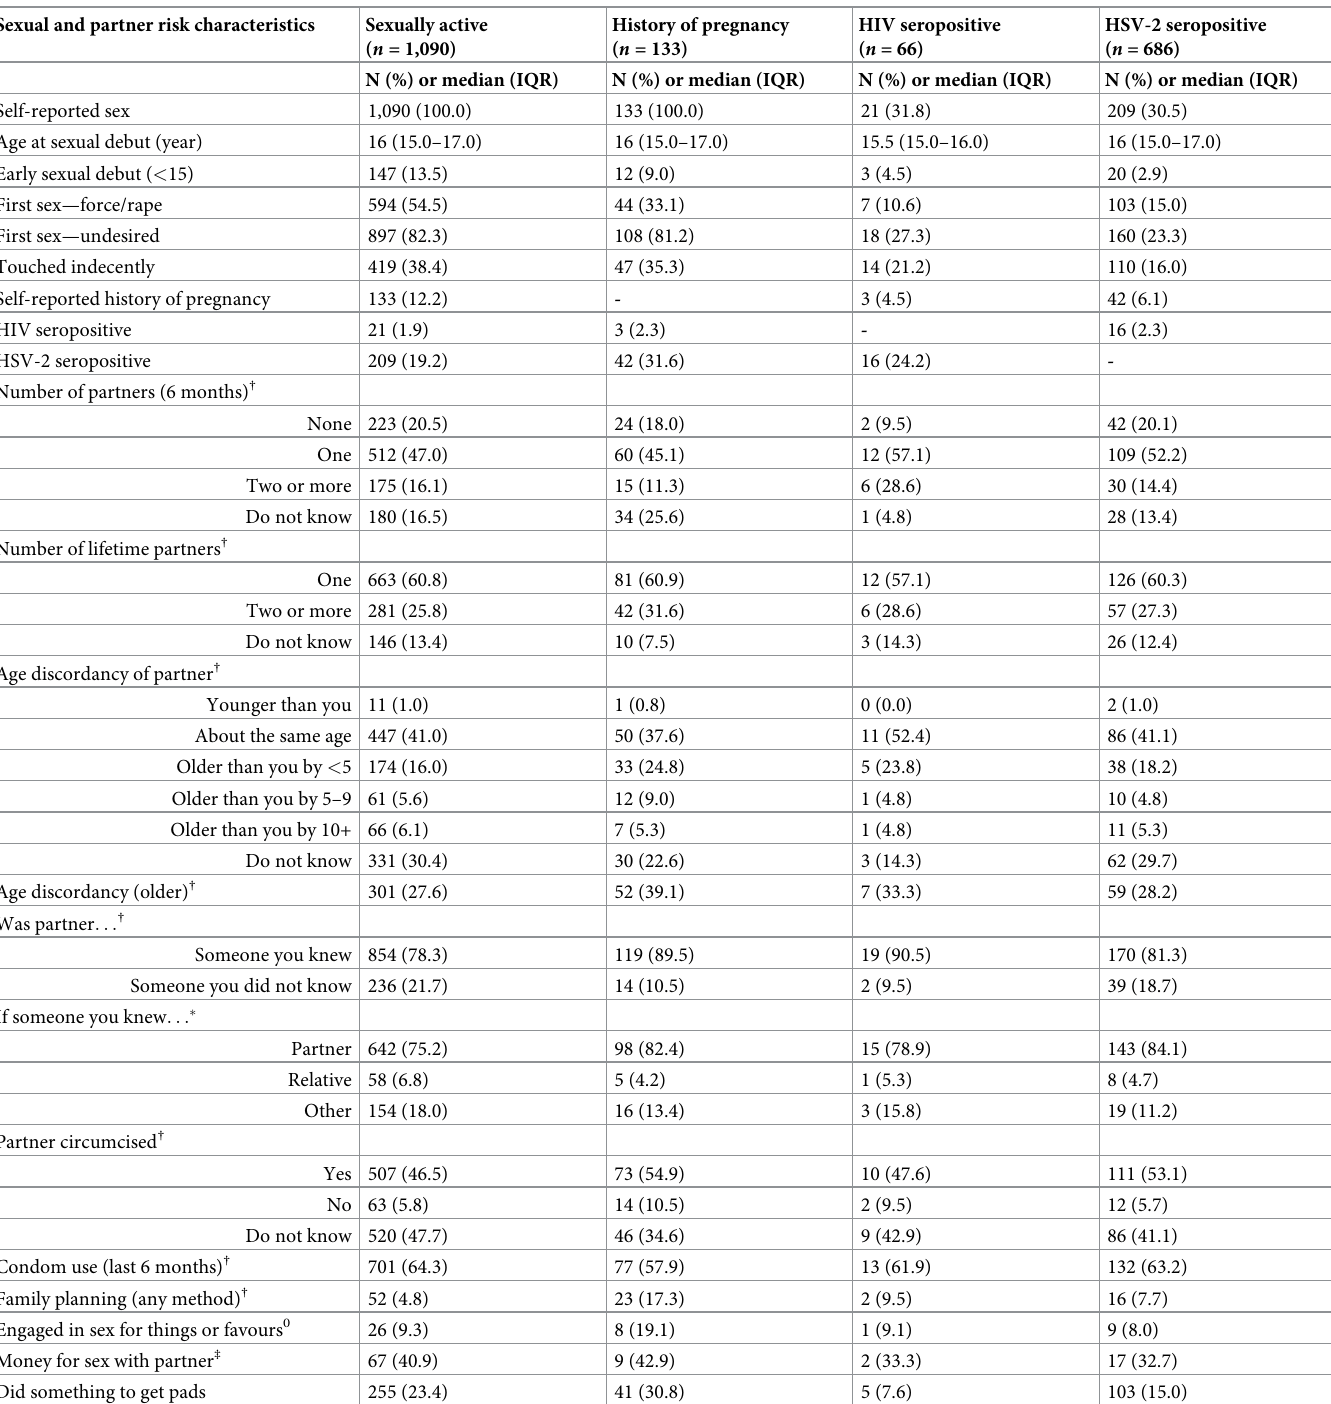
Table 2. Sexual risk and partner covariates by SRH status among 1,090 sexually active girls attending secondary school, Siaya County, western Kenya, 2017–2018. Sexual and partner risk